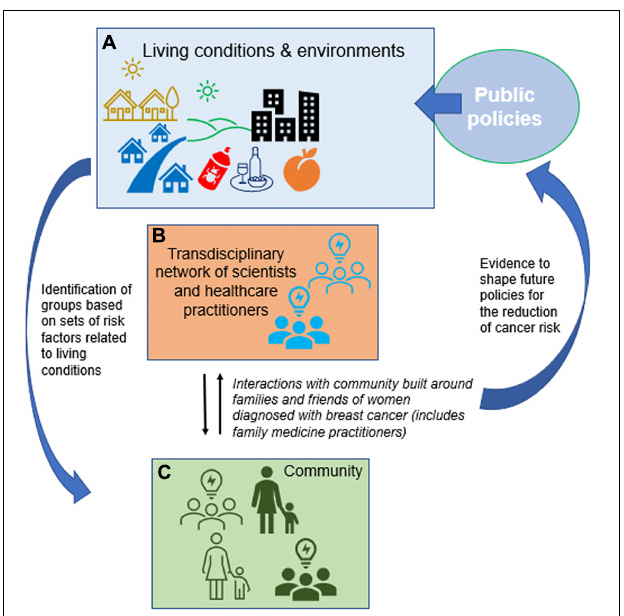
FIGURE 2 | Building communities for research on primary prevention of breast cancer. (A) Public health policies shape most of our environment by regulating pollutants, nutrition and the recreational use of potentially harmful substances, in addition to healthcare access and delivery. Along with lifestyle and social determinants of health, chemical and physical environmental factors influence the risk of developing breast cancer. (B) The transdisciplinary network of IBCN scientists and healthcare practitioners aims to recruit cancer free people (friends, family members) from within the community of women who develop breast cancer to run projects focused on communities representing different sets of risk factors (C) . Outcomes are expected to be the design of interventions to reduce breast cancer risk and an impact on public